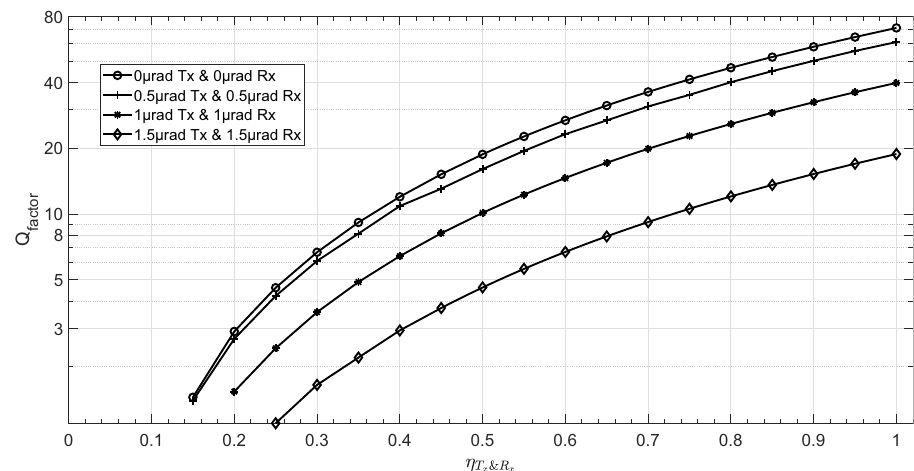
Figure 15: Quality factor ( Q factor ) as a function of the telescope e ffi ciency for di ff erent transmitter and receiver pointing